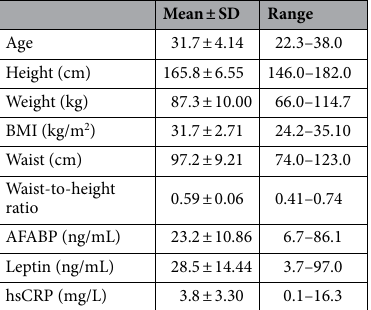
Table 1. Characteristics of the cohort at the examination closest to IVF (n =